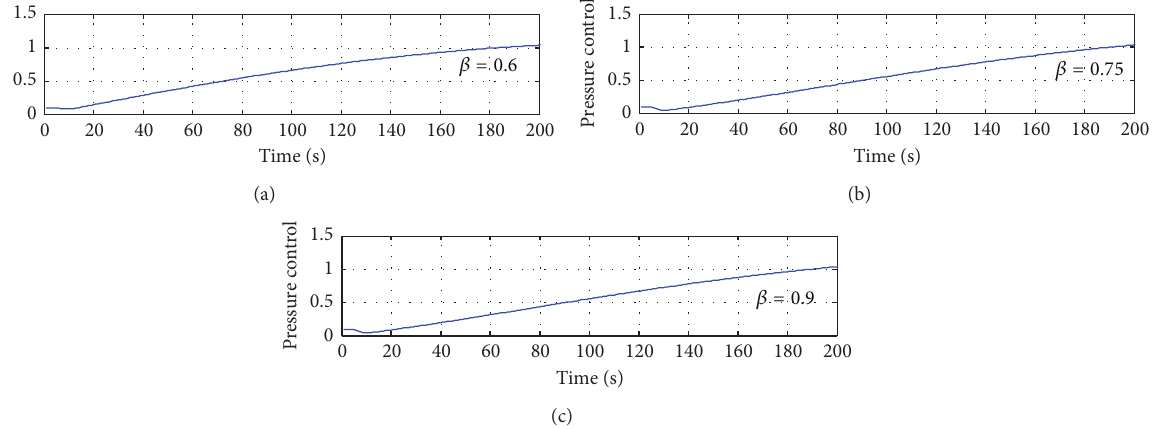
Figure 10: Step response of the fractional order derivative nozzle-flapper-relay for